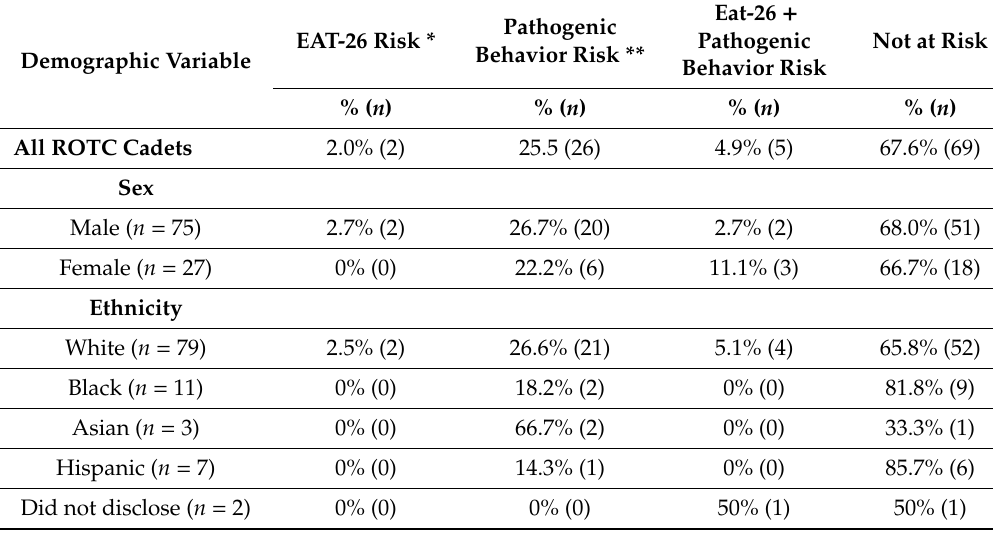
Table 3. ROTC cadets’ type of risk for eating disorder by sex, ethnicity, and military branch presented as % ( n